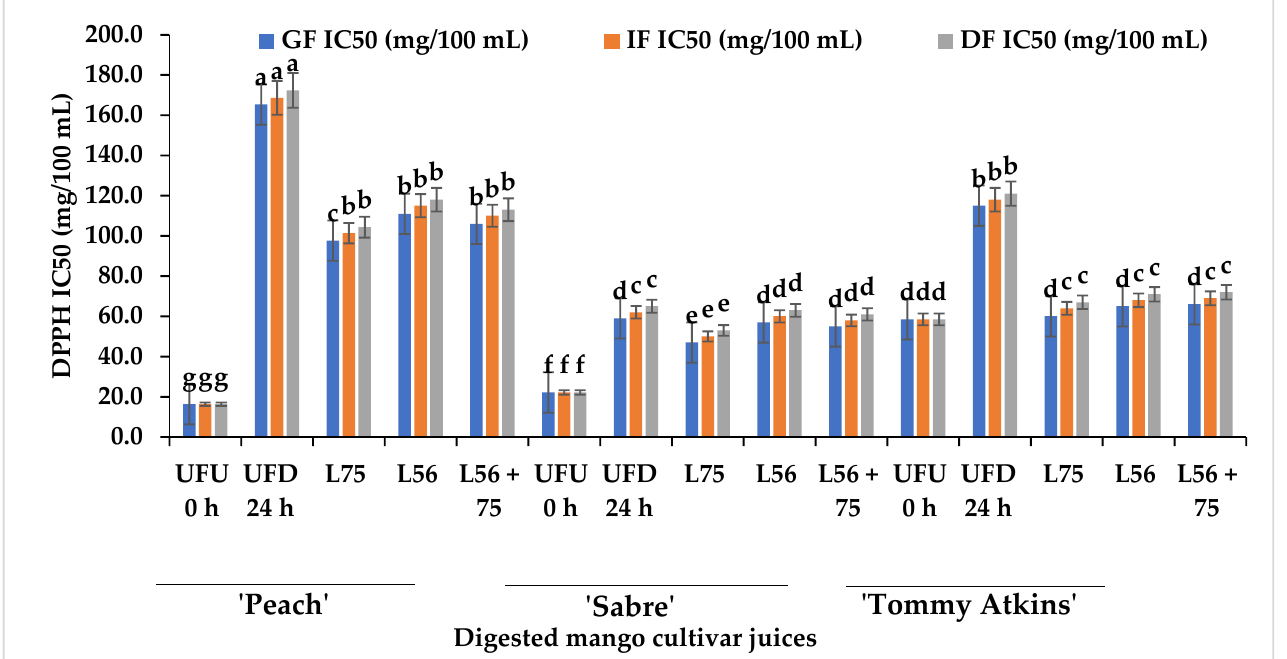
Figure 3. DPPH antioxidant scavenging activity of LAB-fermented MJs from different cultivars after in vitro GI digestion. Bars are mean ± standard deviation and different alphabets on similar colored bars indicate significant difference at p ≤ 0.05. Keys: Ltp. plantarum ( L75 ); Leu. pseudomesenteroides ( L56 ); Leu. pseudomesenteroides 56 + Ltp. plantarum 75 ( L56 + 75) , gastric fraction (GF), Intestinal phase, Dialysis phase (DF); 2-diphenyl-1-picrylhydrazyl (DPPH); UFU 0 h—raw unfermented